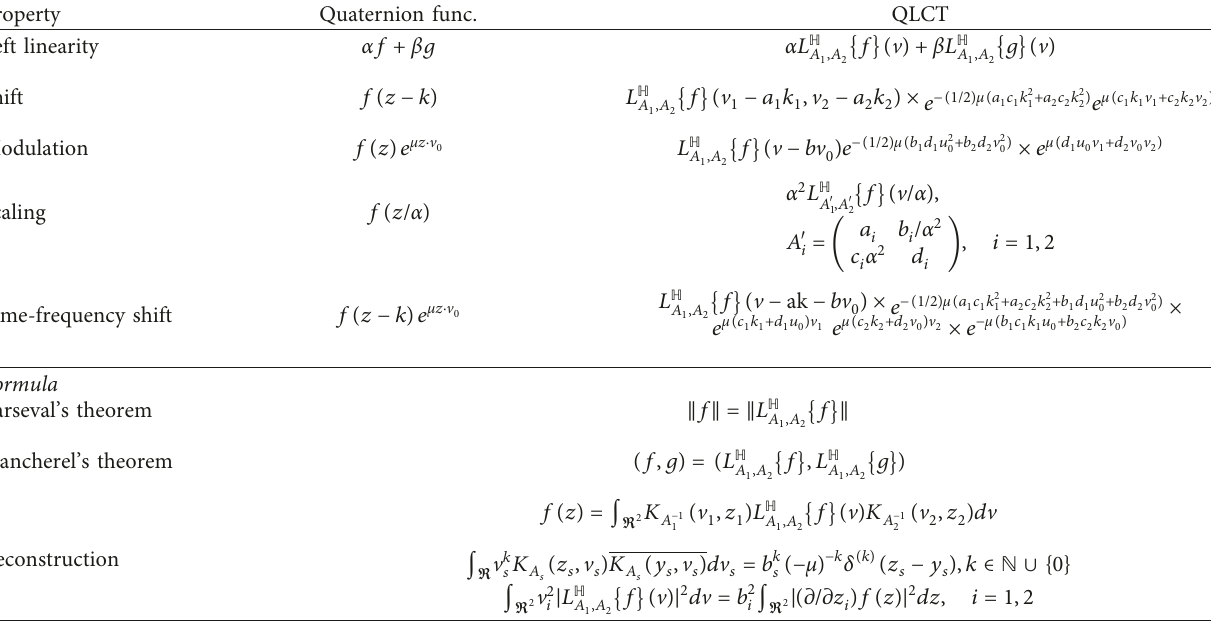
Table 1: Useful properties of the